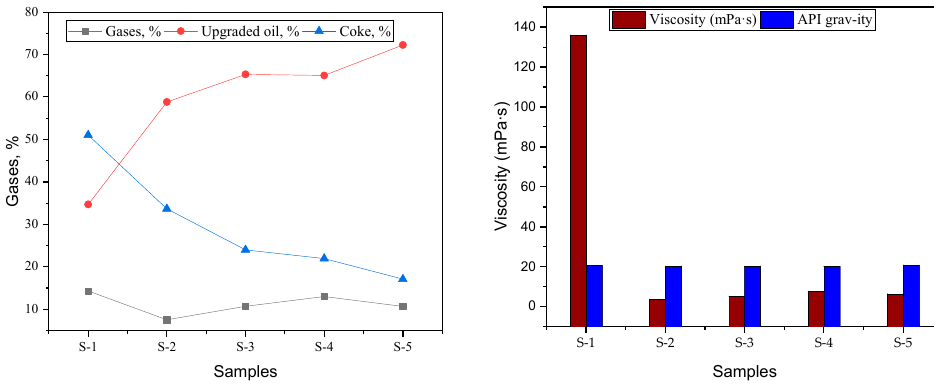
Figure 3. Yield of hydrogen after hydrothermal upgrading of extra-heavy oil.